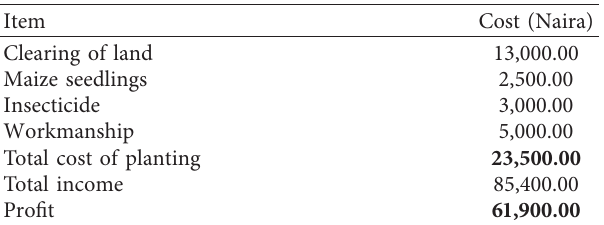
Table 1: Dominion farm, Ife, Osun State, Nigeria (cost of planting maize per